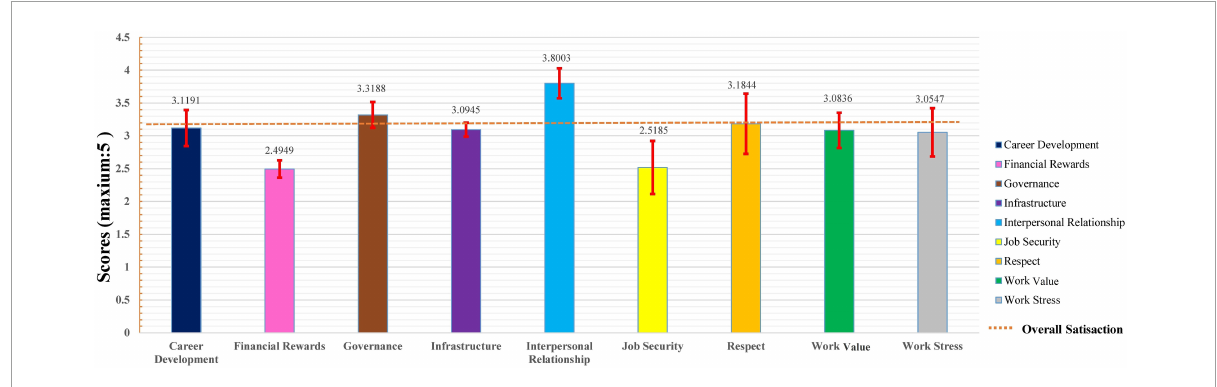
FIGURE6 Summary results of different themes and the scores of overall job